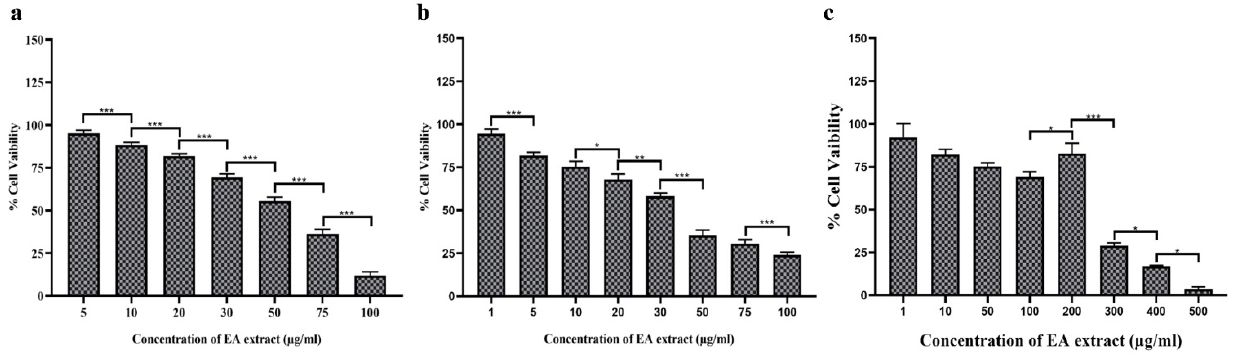
Figure 7. ( a ) Cytotoxic effect of EA extract of P. oxalicum against HuT-78 cell line (Human T cell lymphoma cell line), ( b ) MDA-MB-231 (breast cancer cell line) and ( c ) MCF-7 cell line (Human breast cancer cell line). All experiments were performed in triplicate. p -value was calculated by comparing means ± SD of percentage of cell viability of cancer cell, using one-way ANOVA followed by Tukey to determine statistical significance, which are as follows; *** p ≤ 0.001; ** p ≤ 0.002; * p ≤ 0.033. Table 3. Cytotoxic activity of EA extract of P. oxalicum associated with the leaf of A. rohituka .